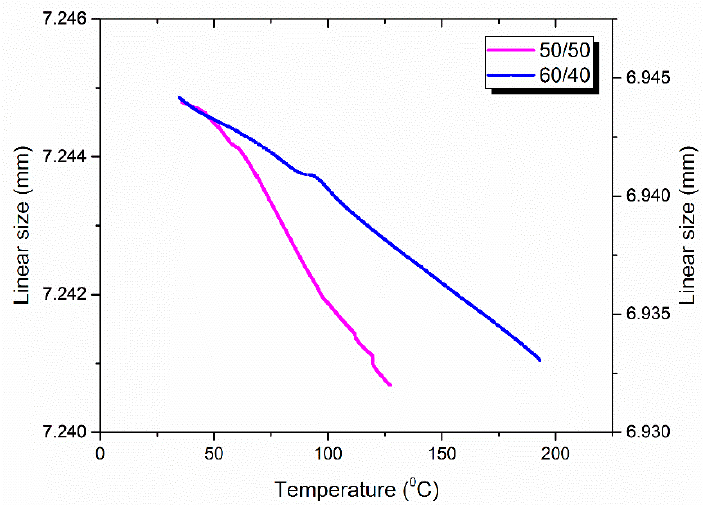
Figure 15. Typical CTE curves investigated in the direction parallel to the layers of reinforcement.